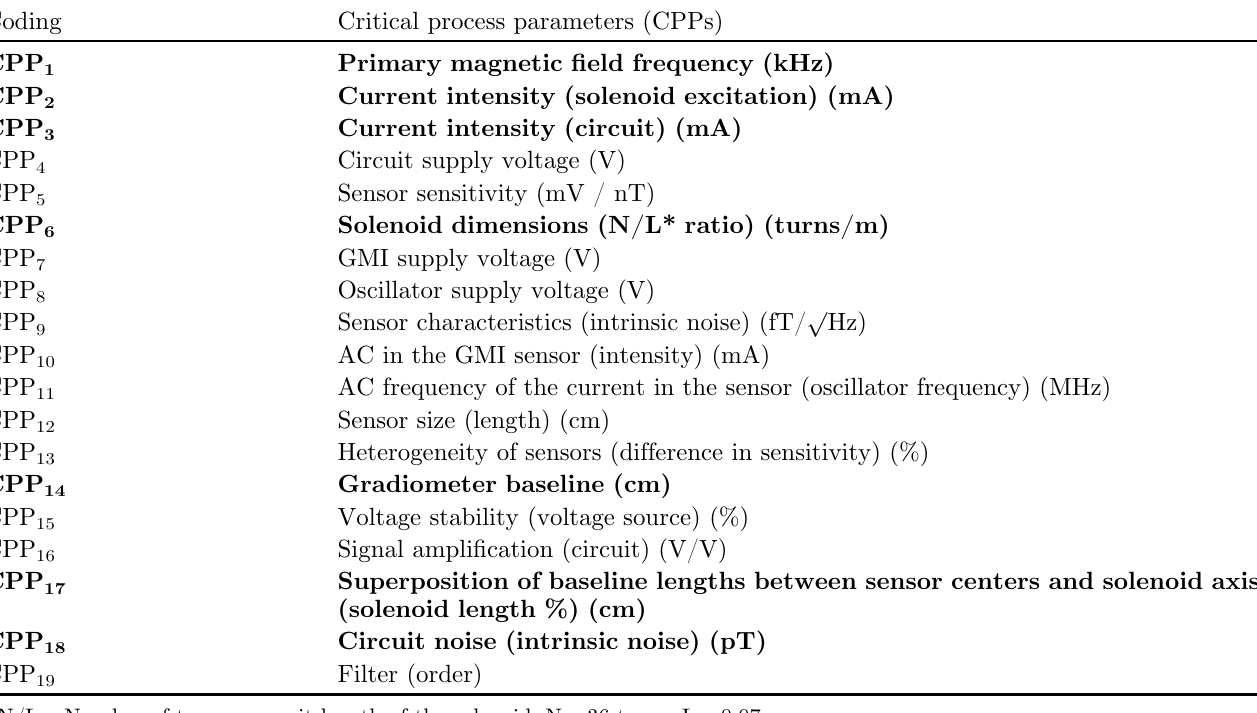
Table 3. Critical process parameters (CPPs) associated with the measurement system for biomedical application. Coding